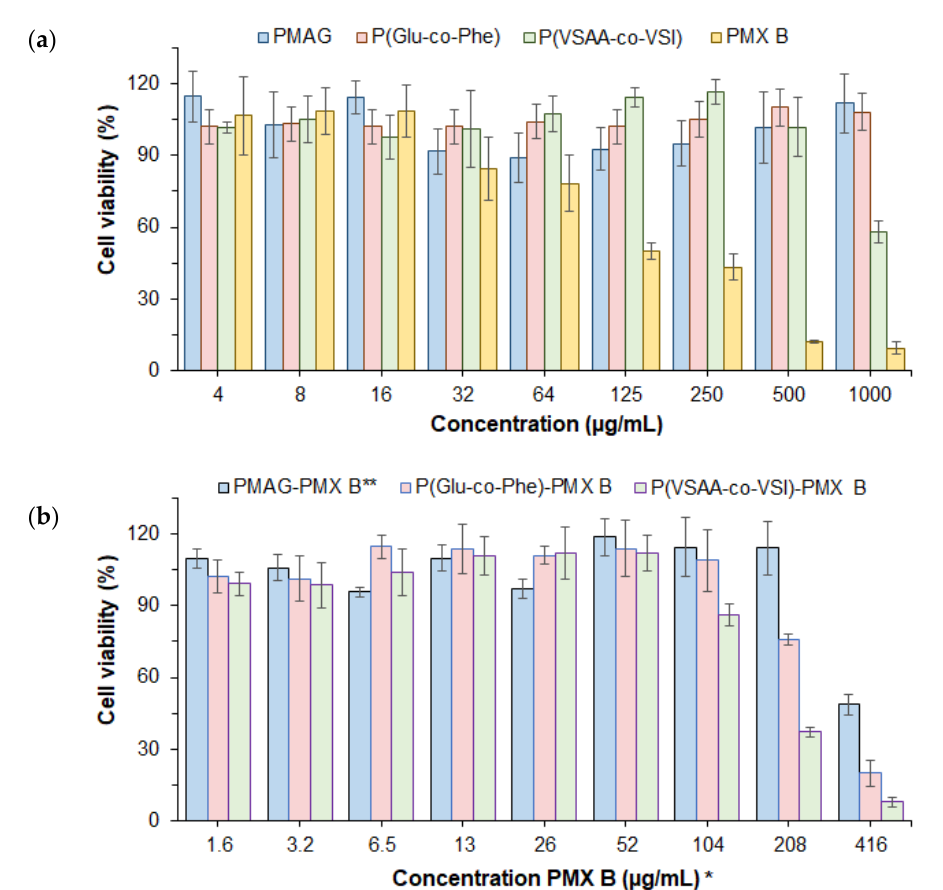
Figure 6. Viability of HEK 293T cells incubated in the presence of free polymers and polymyxin B ( a ) and their conjugates ( b ) for 48 h (* conjugates were tested relative to PMX B concentration; ** PMAG − PMX B conjugate was tested with the reduced aldimine bonds). Data are presented as mean ± SD (n = 4). Table 7. IC 50 values for free polymers and PMX B, as well as their conjugates (HEK 293T cells, MTT, 48 h): * conjugates were tested relative to PMX B concentration; ** PMAG − PMX B conjugate was tested with the reduced aldimine bonds. Data are presented as mean ±